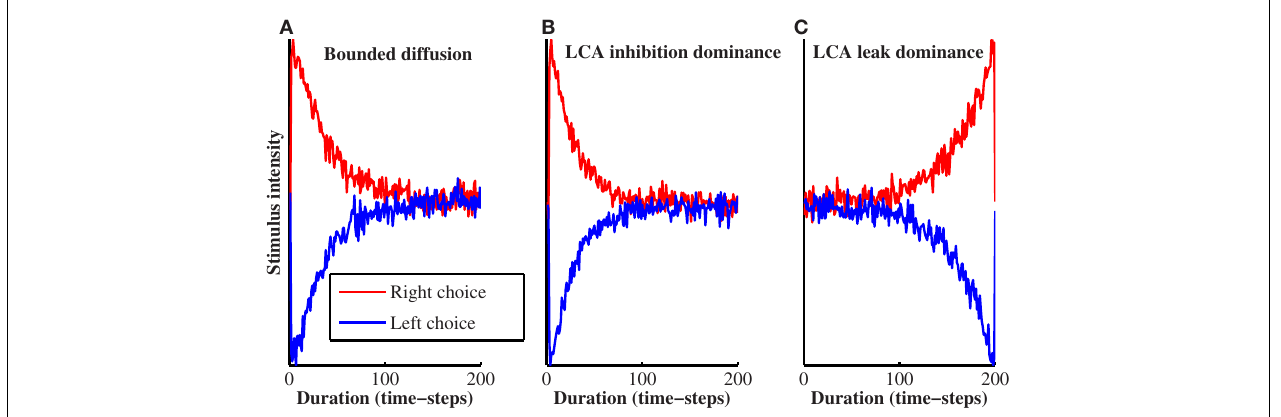
FIGURE 4 | Reverse correlations for the bounded diffusion (A) and the leaky competing accumulators in inhibition-dominance (B), leak-dominance (C) models, showing the average input of the winning (red) and losing (blue) units, in zero-coherence simulated trials.